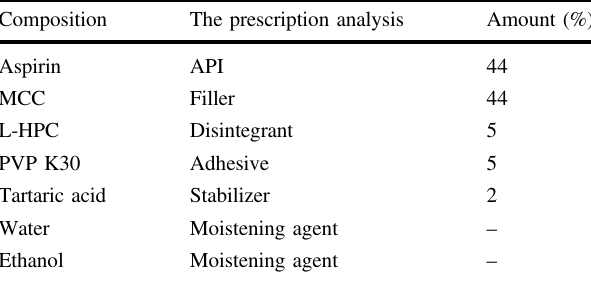
Table 2 The composition of prescription of aspirin drug-loaded pellets Composition